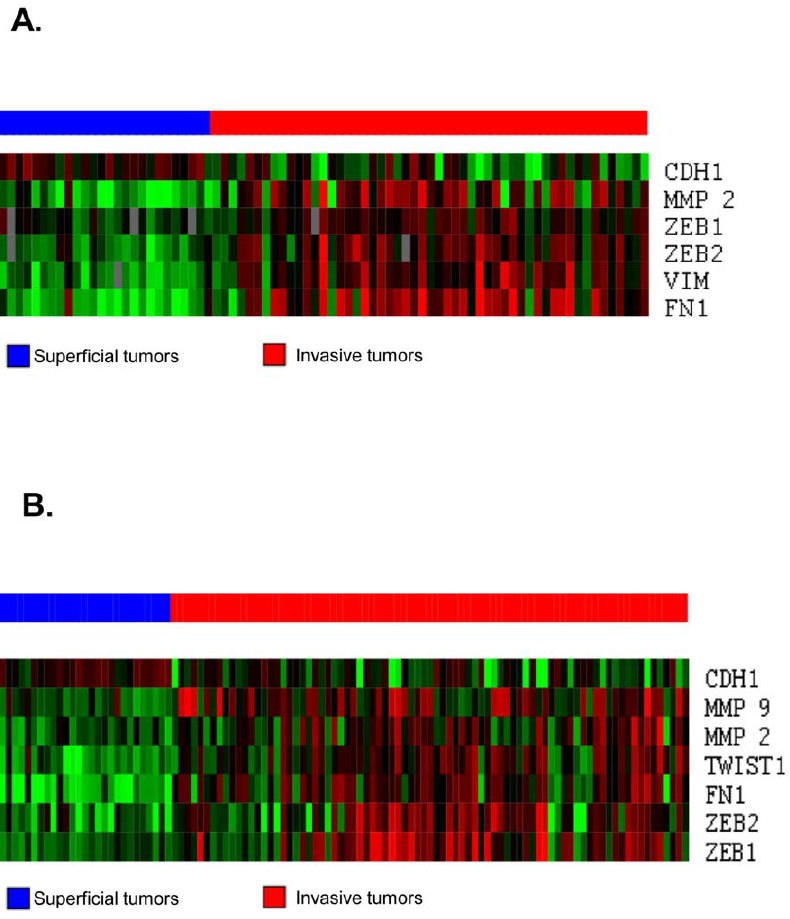
Figure 1. EMT marker expression in bladder cancers including primary tissue. A & B: All EMT marker genes with significant differences in expression (P , 0.001) in 2 independent publicly available datasets. An in-house cDNA microarray with 10368 probes was used in A [13]. The HU-133A Affymetrix platform was used in B [14].